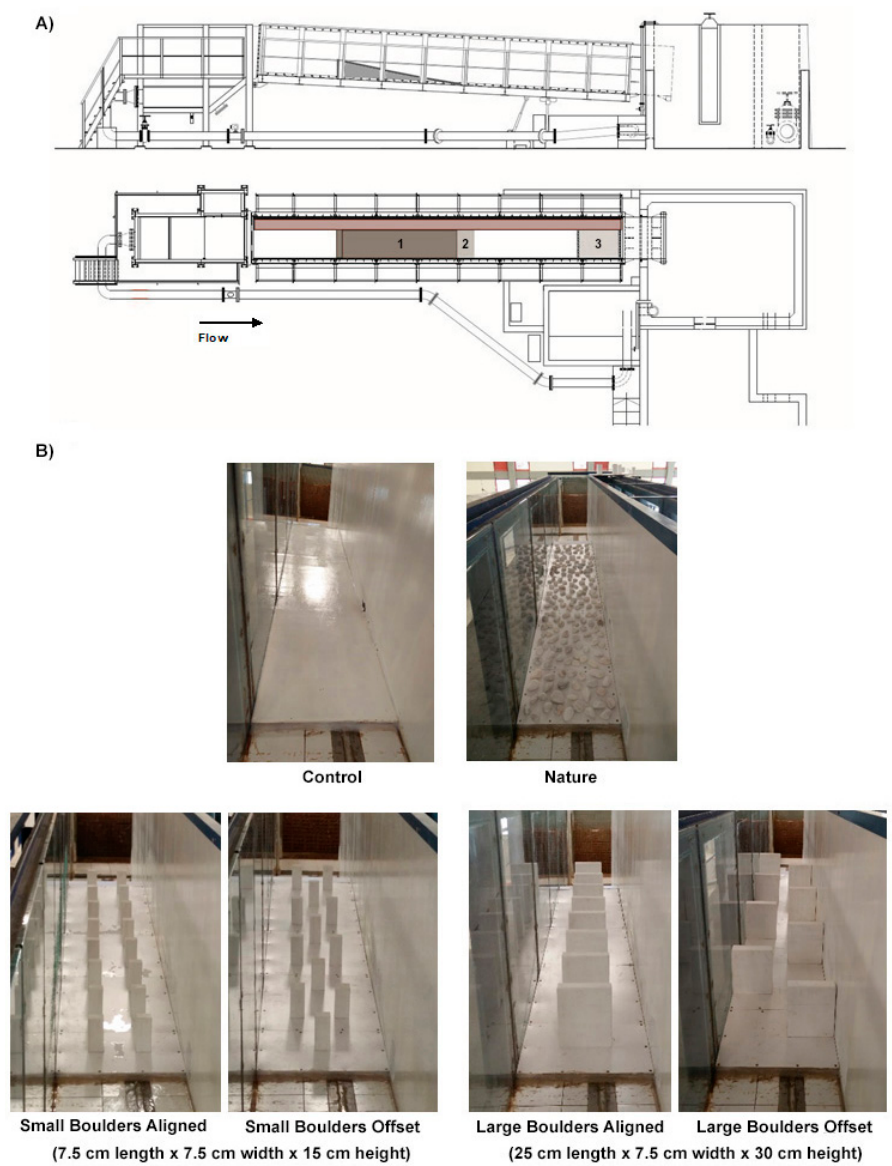
Figure 1. ( A ) Scheme of the experimental flume, representing a side view of the channel on a slope of 3% (above), and a top view (below) with the location of (1) the experimental low-head ramped weir (ramp 3.00 m long on a slope of 10%, with a 0.20 m weir crest, located 2.50 m upstream the acclimation area), (2) the approach area (the 0.30 m 2 shaded area immediately downstream of the ramp toe), and (3) the acclimation area (the 0.60 m 2 shaded area between the two removable fine mesh panels located downstream); ( B ) Images of the six configurations tested, contemplating the Control ramp (without substrates) and the retrofitted designs selected: Nature (ramp with cobbles randomly distributed), Small Boulders Aligned and O ff set (boulder dimensions 7.5 cm long × 7.5 cm wide × 15 cm high), and Large Boulders Aligned and O ff set (boulder dimensions 25 cm long × 7.5 cm wide × 30 cm